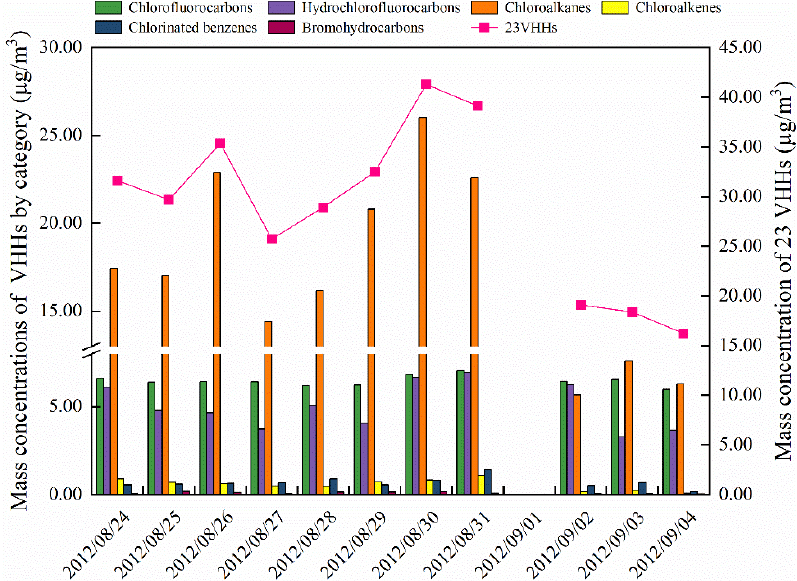
Figure 4. Daily variation of the mass concentrations of volatile halogenated hydrocarbons in the study area.